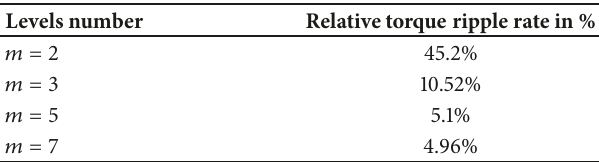
Table 1: relative torque ripple rate as function of the inverter levels